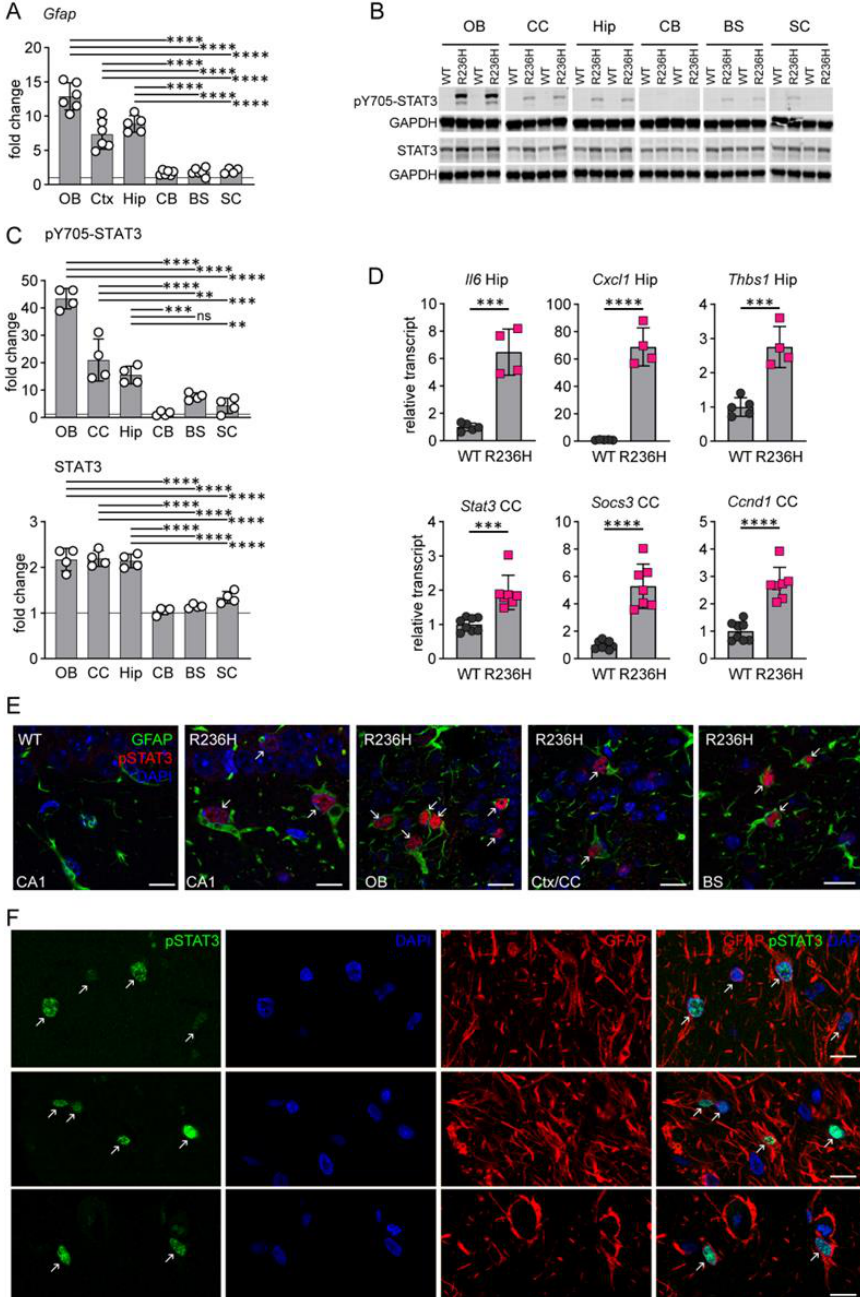
Figure 1. STAT3 activation in AxD. ( A ) Comparison of fold increase in Gfap transcript among different brain regions and spinal cord in Gfap +/R236H mice as measured by qPCR. Results for olfactory bulb (OB), cortex (Ctx), hippocampus (Hip), cerebellum (CB), brainstem (BS) and cervical spinal cord (SC) are shown (males at 8 weeks, ANOVA with Sidak’s post-tests, data reanalyzed from Figure 2